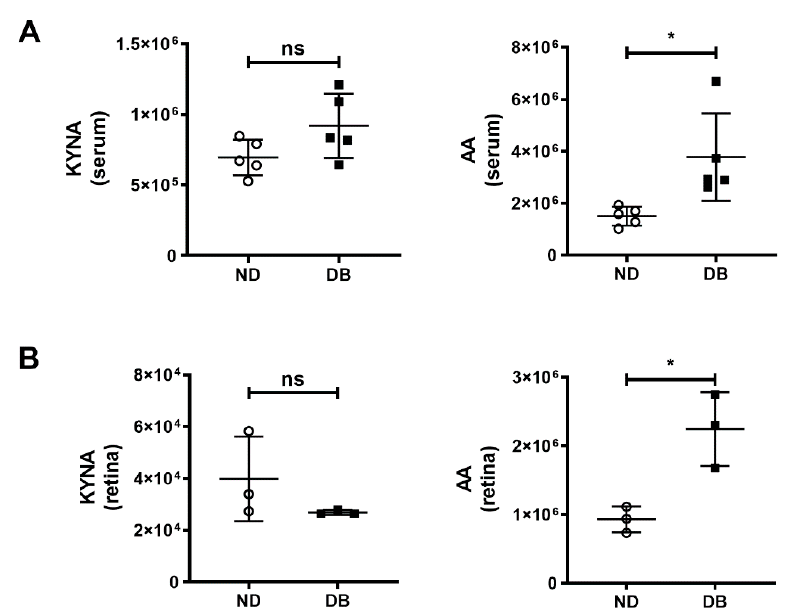
Figure 6. The KYNA and AA were measured by LC-MS / MS (area under curve) in ( A ) serum ( n = 5) and ( B ) retinas ( n = 3) of non-diabetic (ND) and diabetic mice (DB). The KYNA levels in the serum and retina were not significantly di ff erent but the AA levels were higher in diabetic mice than in non-diabetic mice. The graphs represent the means ± SD of number of measurements mentioned above. ns = not significant and * p < 0.05.